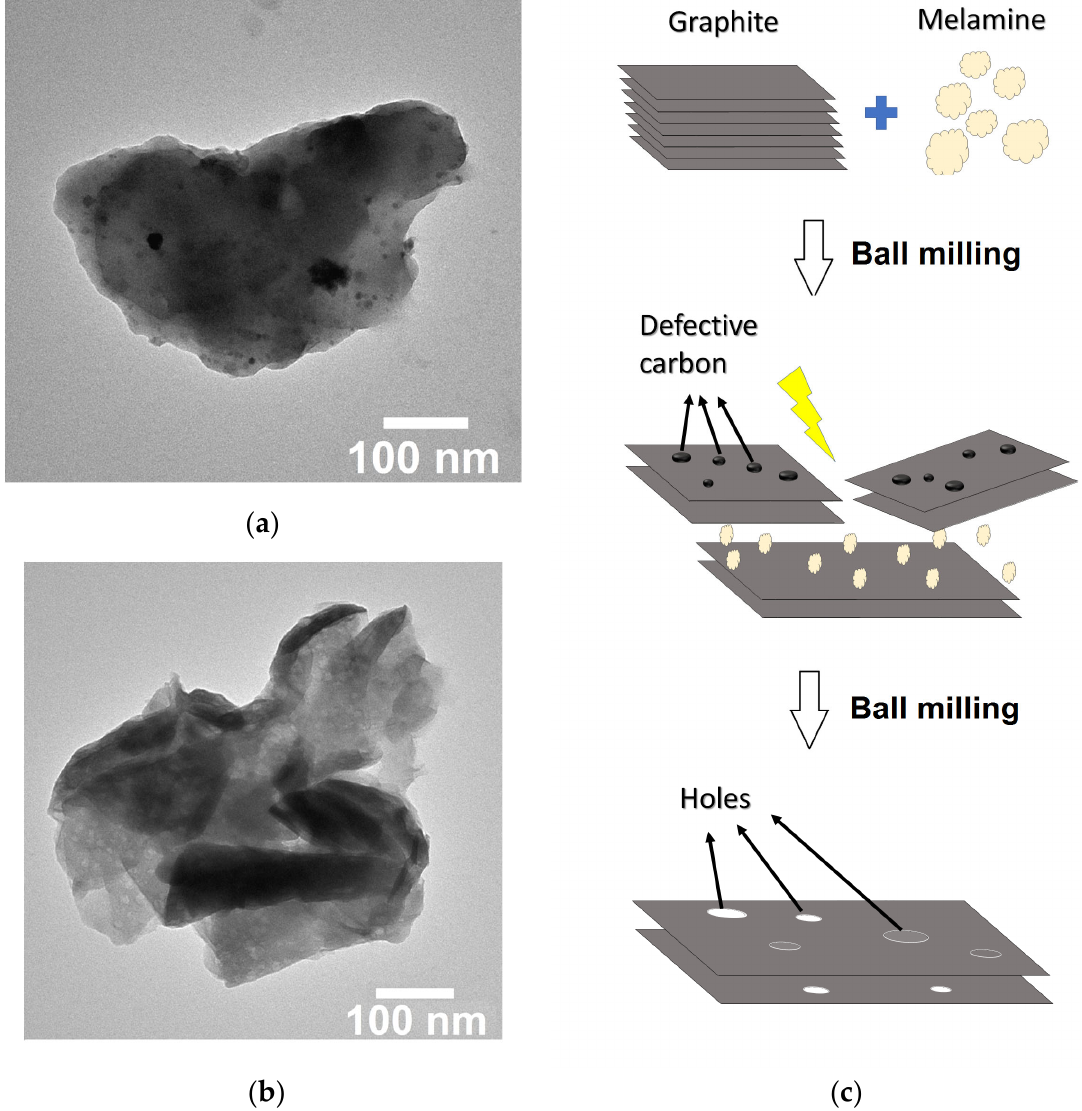
Figure 5. ( a ) TEM image of defective multilayer graphene as an intermediate product, ( b ) TEM image of the holey multilayer graphene, and ( c ) schematic of the synthesis process of holey multilayer graphene via high ‐ energy ball milling in presence of melamine.